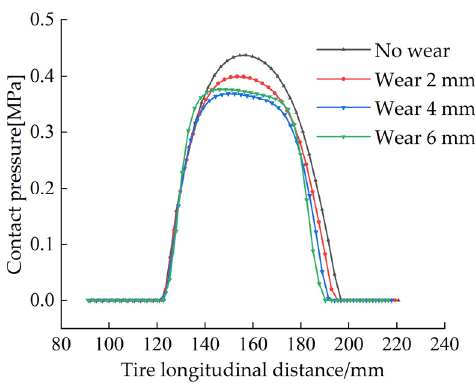
Figure 22. Curves of tire contact area and longitudinal contact length under different wear amounts.